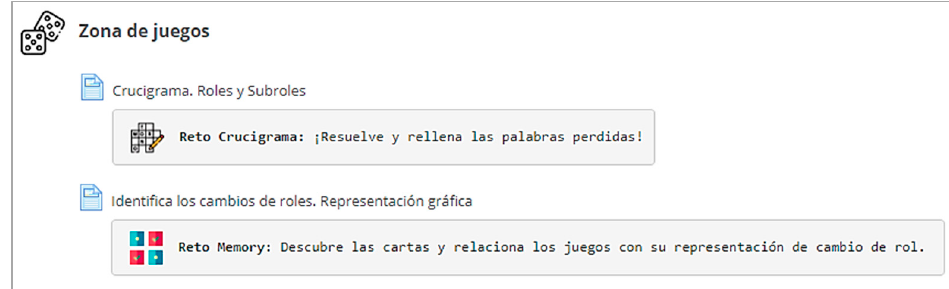
Figure 3. Dynamics of individual gamification by challenges. EGi group.